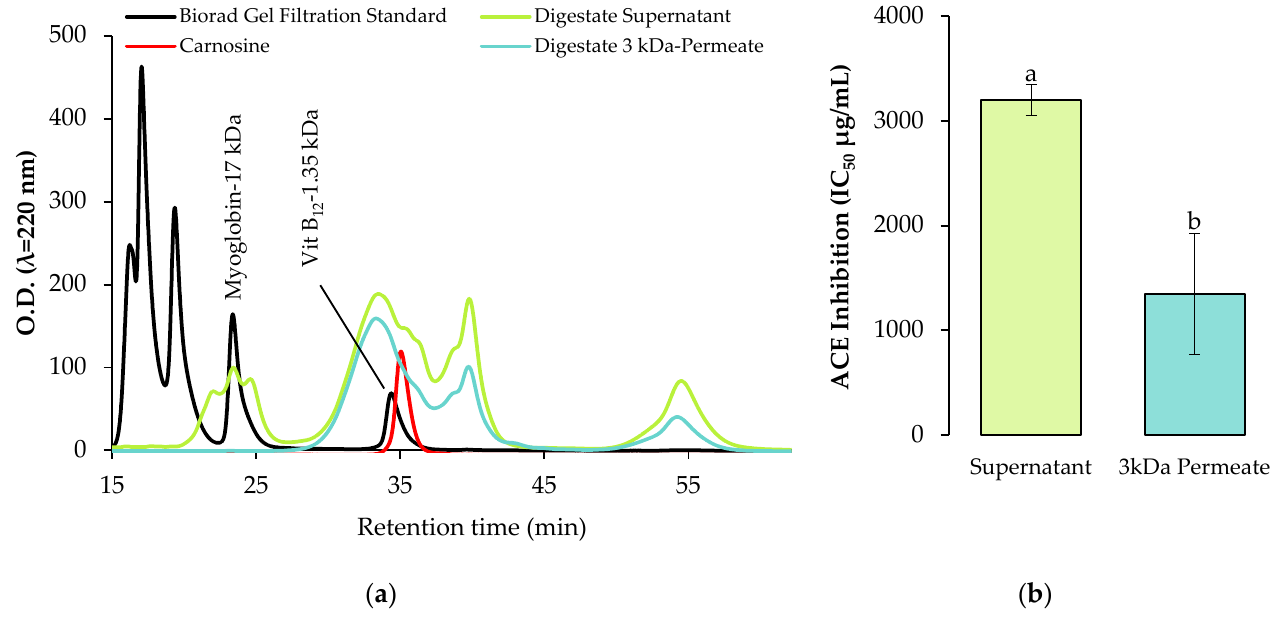
Figure 4. ( a ) Molecular weight distribution of peptides; and ( b ) exhibited antihypertensive activity of the faba bean digestate (variety Fabelle) before and after 3 kDa cut ‐ off ultrafiltration. The ACE inhibition data are expressed as mean ± standard deviation and means without a common letter differ ( p < 0.05) as analyzed by one ‐ way ANOVA and the Tukey’s test. Table 2. Composition analysis of the 3 kDa permeate of legume digestates.